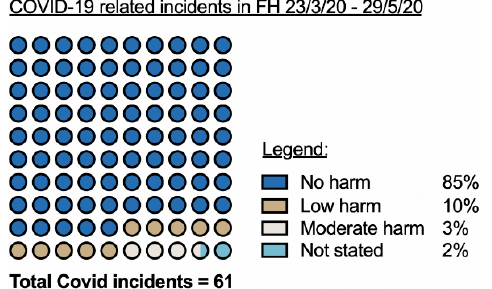
Figure 1. The degree of harm resulting from incidents deemed to be COVID-19-related in the